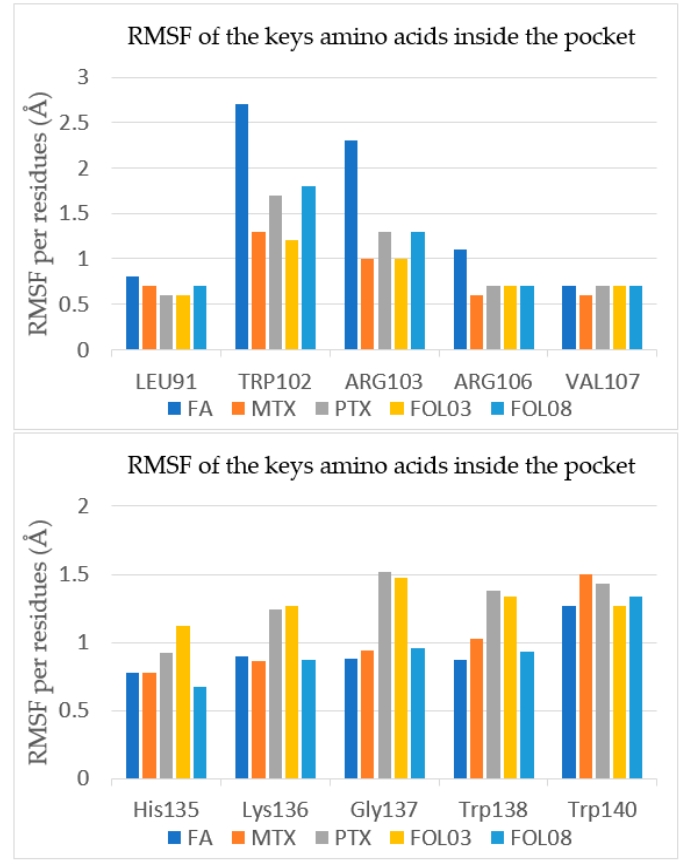
Figure 13. The RMSF values for the significant amino acids of the FR α active site after interacting with the selected ligands throughout a 100 ns MD simulation.